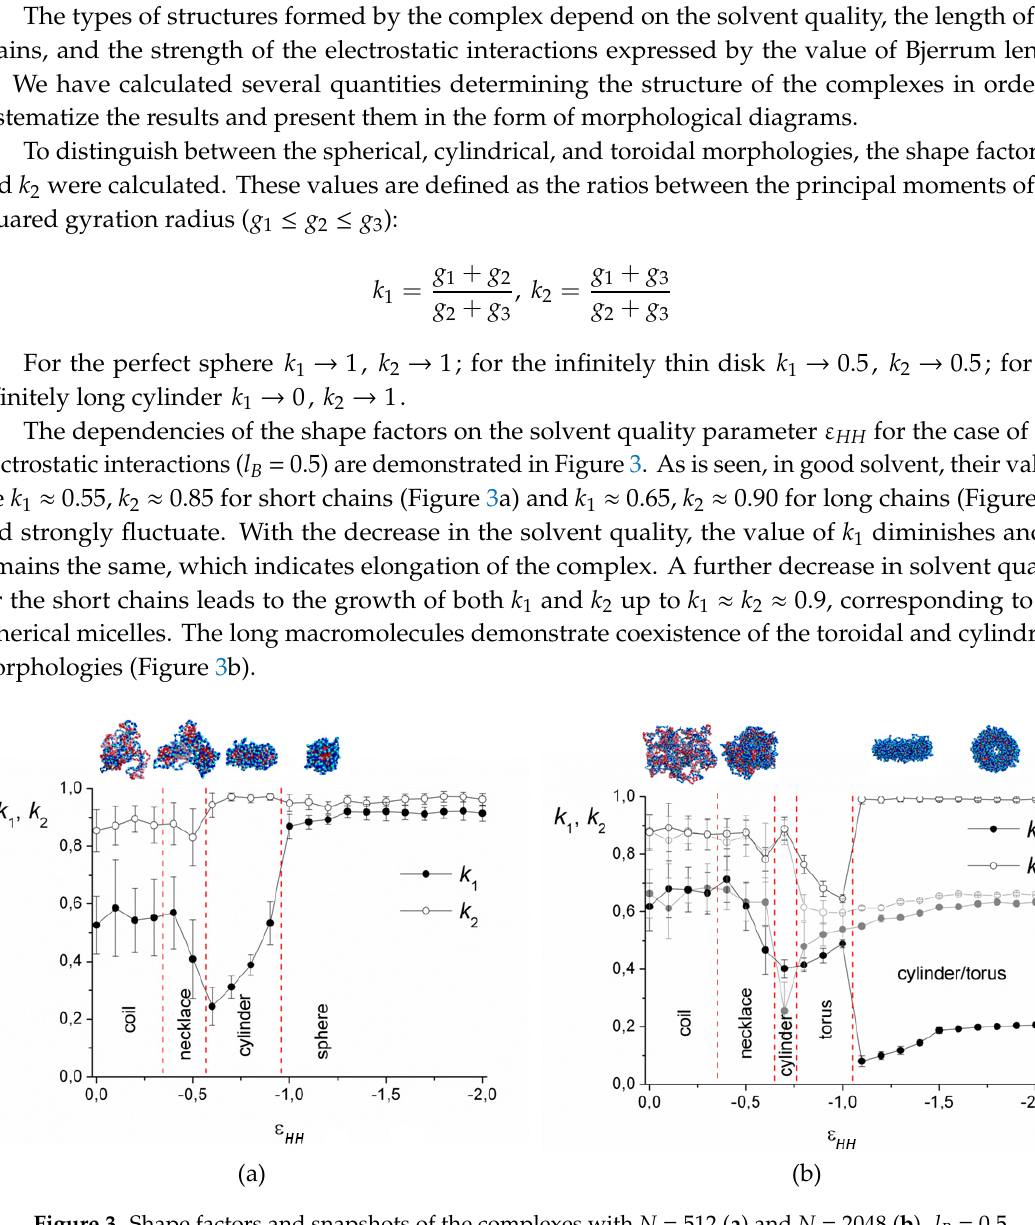
Figure 2. The snapshots of the typical morphologies formed by the complex: l B = 4, N = 1024,